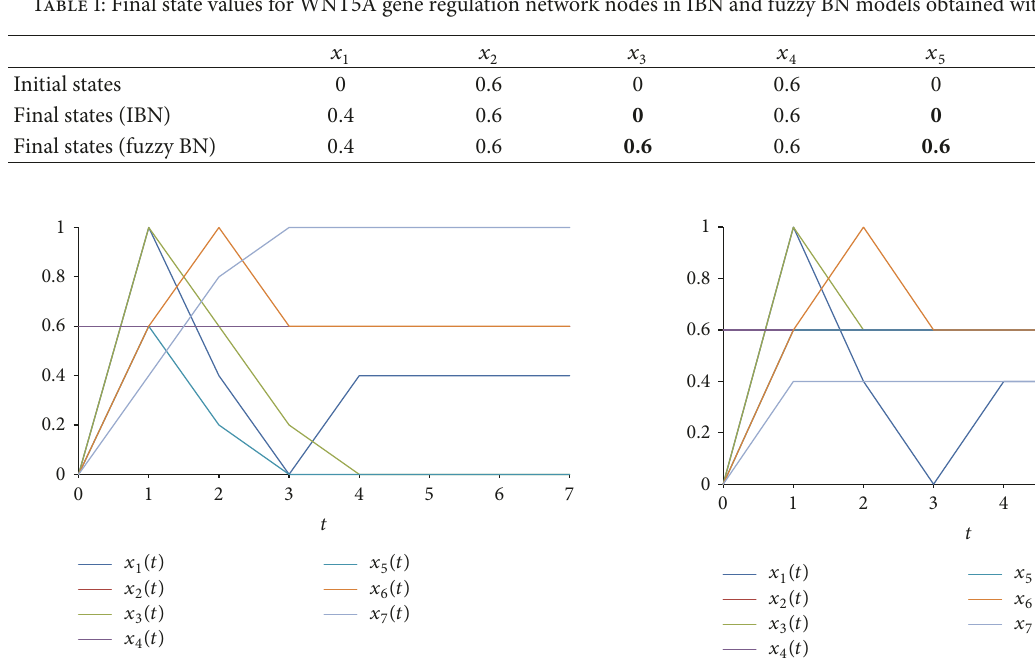
Figure 4: Dynamics of the fuzzy BN model for WNT5A gene reg- ulation with initial state conditions 𝑋(0) = [0; 0.6; 0; 0.6; 0;0; 0] and minimum operator used as 𝑡 -norm. The fuzzy BN model reaches the point attractor in 4th iteration 𝑋(4) = [0.4; 0.6; 0.6; 0.6; 0.6; 0.6; 0.4]